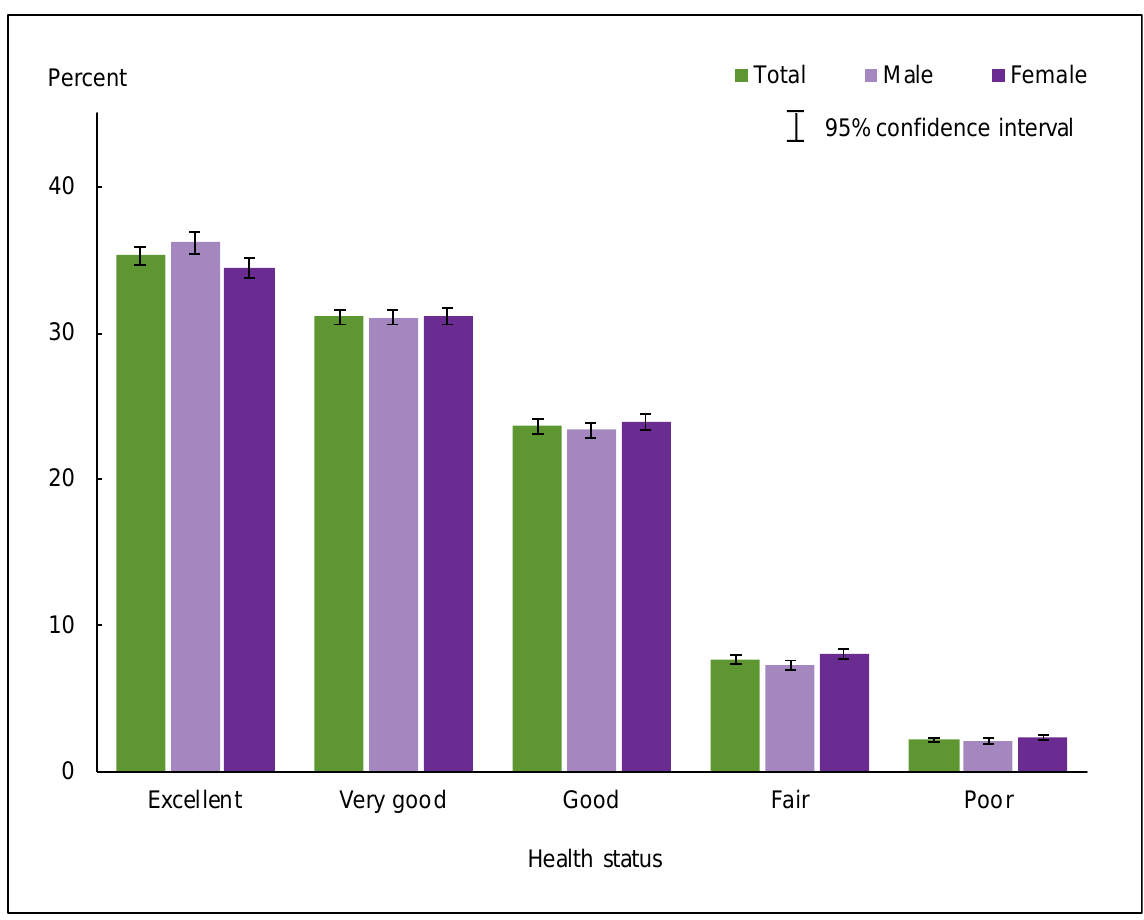
Figure 11.2. Percent distribution of respondent–assessed health status for all ages, by sex: United States,